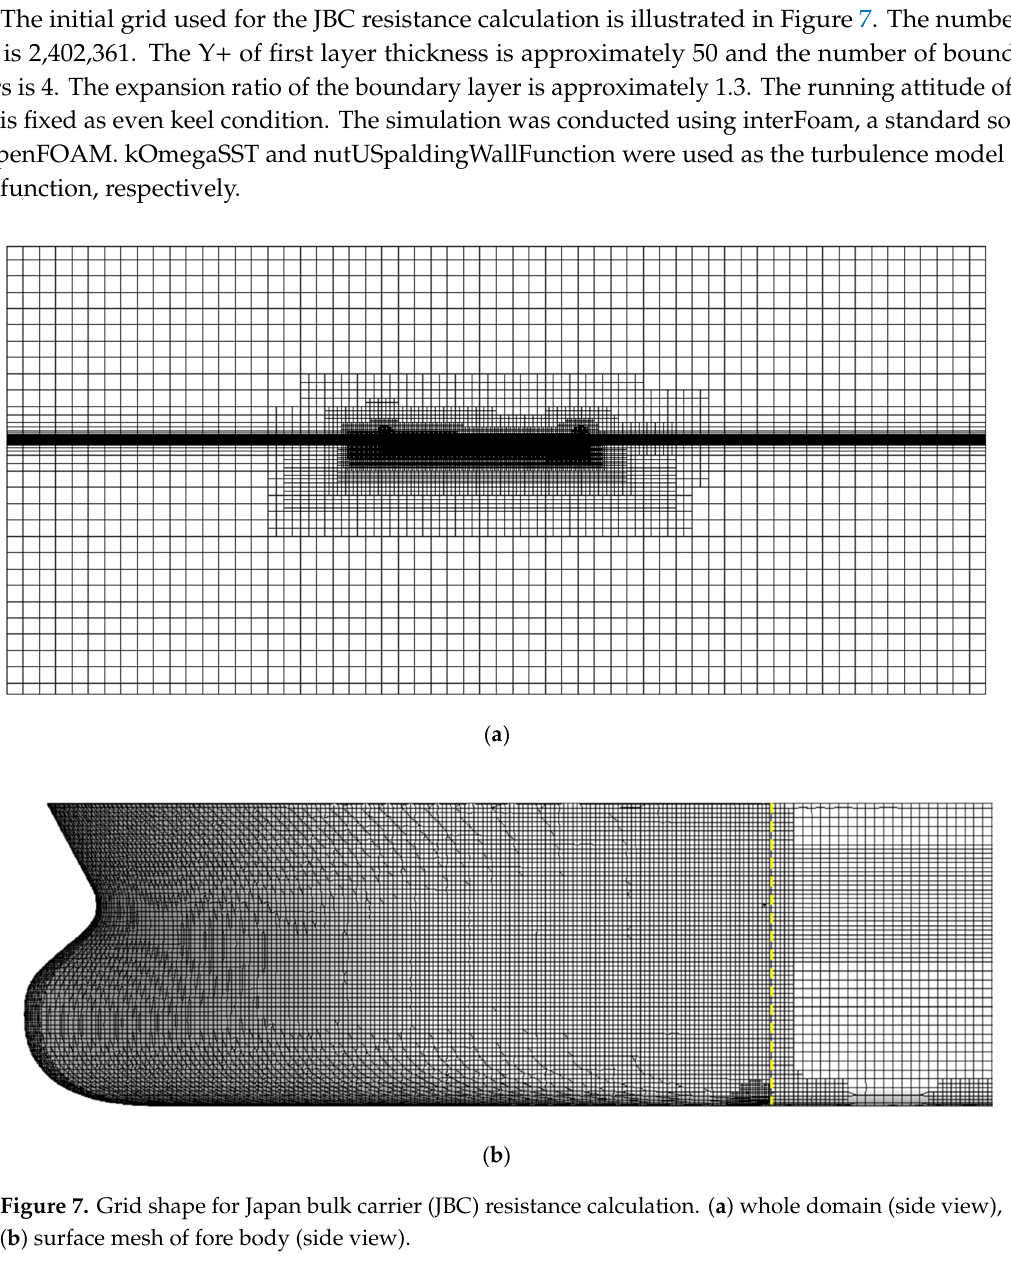
Figure 8. Definition sketch of control points for hull form variation.